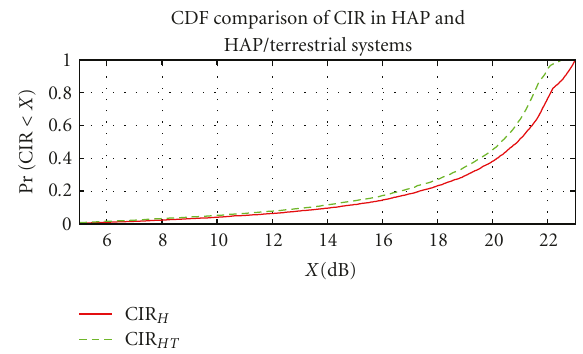
Figure 13: Comparison of the DL CIR values in HAP (CIR H ) and HAP/terrestrial (CIR HT ) WiMAX coexistence